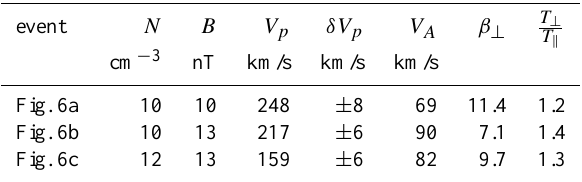
delays between the satellites implied from the alignment of solitons are t 12 =12.10, t 13 =18.00, t 14 =7.11 s in the case of Fig. 6a. The computed velocity of the structure is V s =[ − 130, 25, 66] km/s, and V sp =43 km/s. The ion flow measured by CIS on C1 and C3 satellites is V p =[ − 197, − 23, − 145] km/s